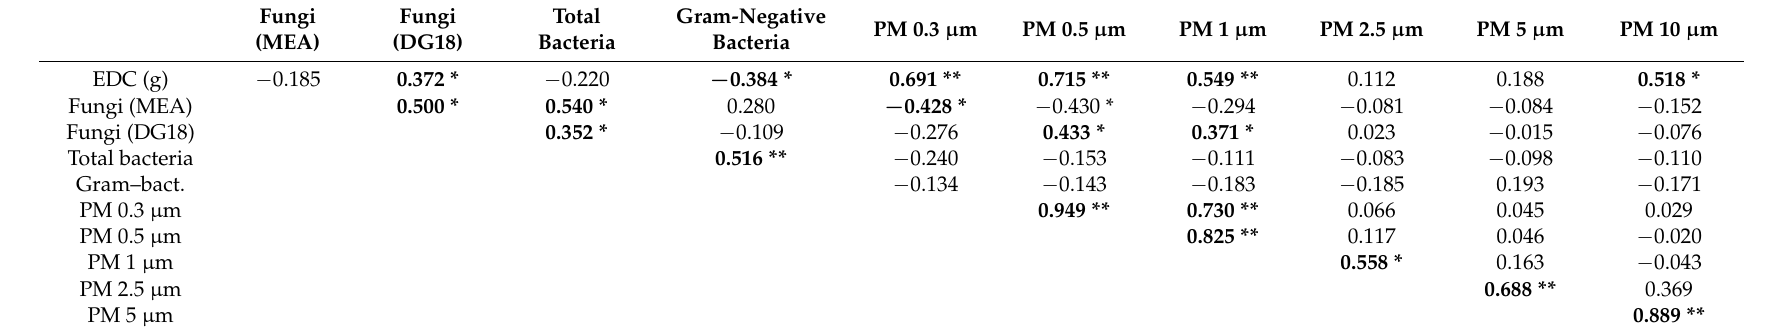
Table 5. Results of Spearman correlation between bioburden, EDC weight and particles mass (PM 0.3 µ m to PM 10.0 µ